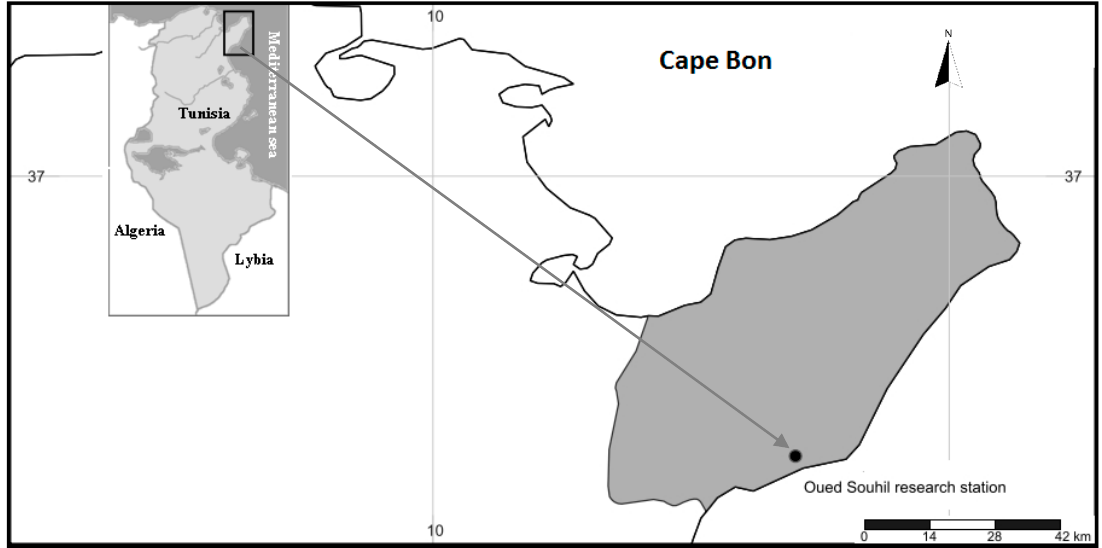
Figure 1. Map of the experimental site (Oued Souhil, Nabeul).